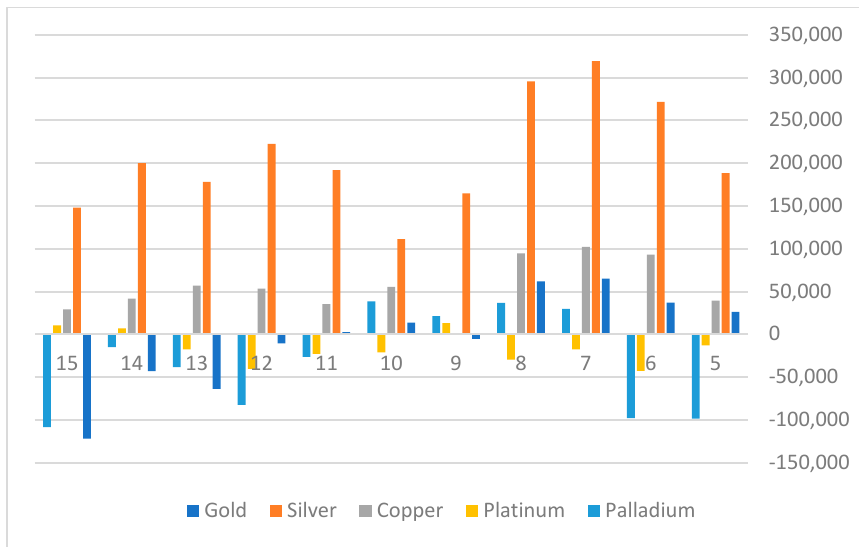
Figure 5. Net profits trading results of Darvas boxes strategy.